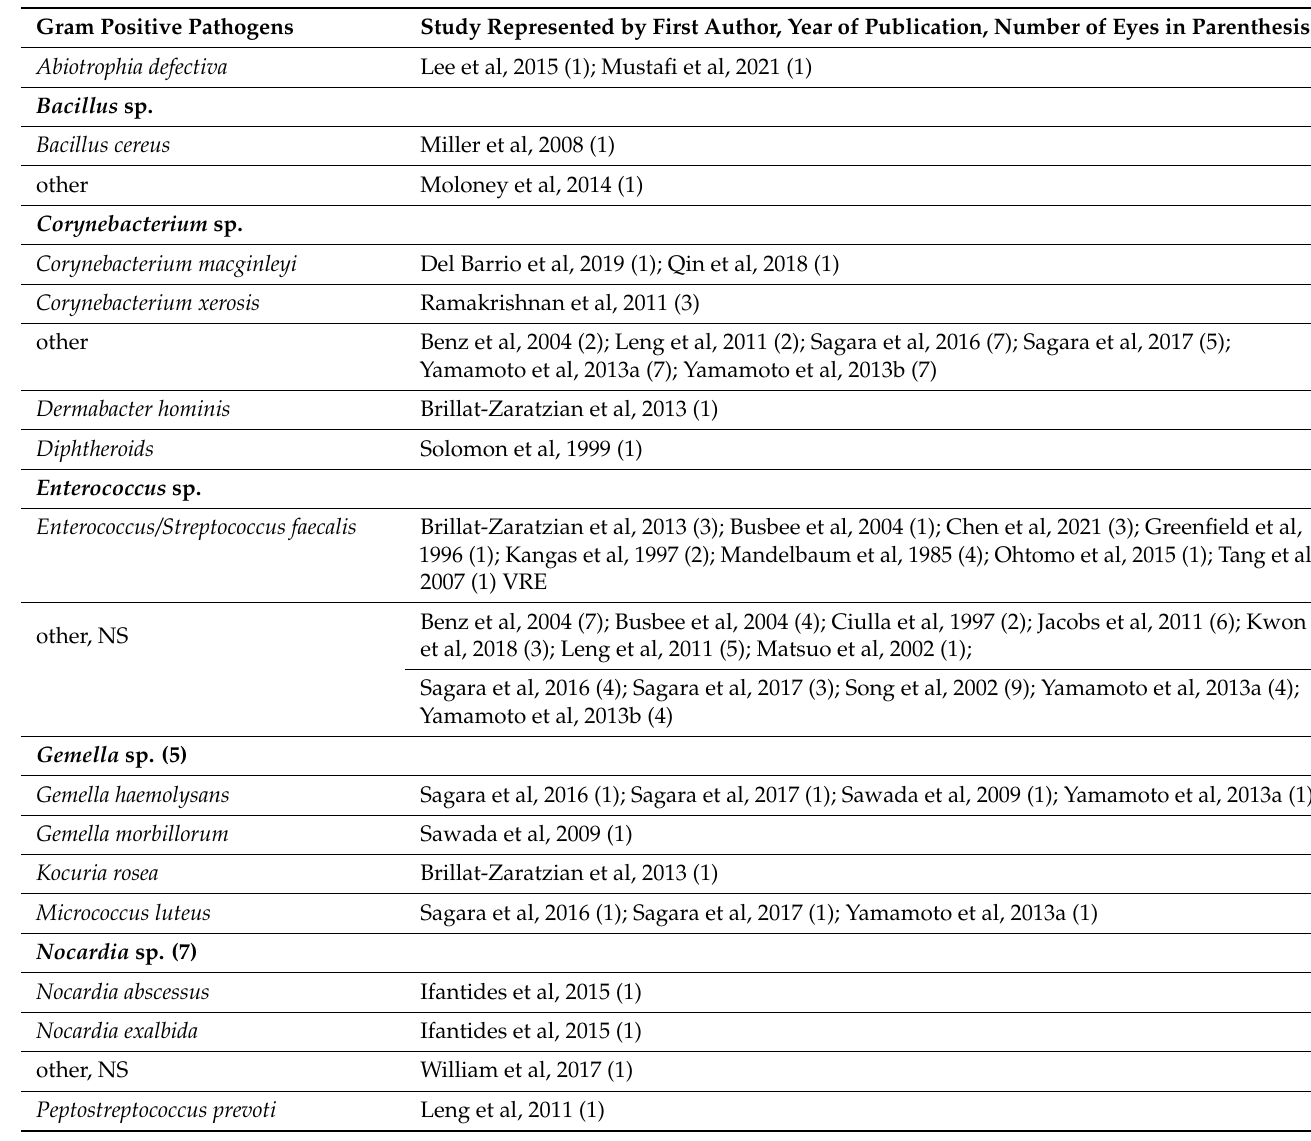
Table 1. Grampositive pathogens causing